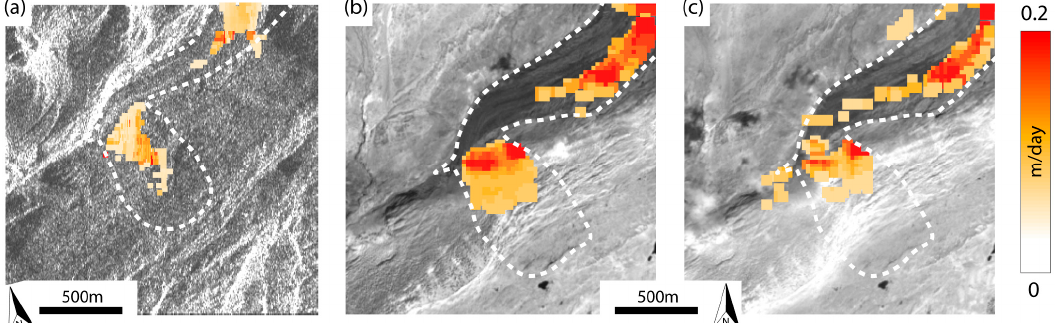
Figure 4. Best results obtained with the DIC analysis applied on the Sentinel-1 and Sentinel-2 datasets over the Moosfluh unstable slope. White boundary delineates the approximate area of the Aletsch glacier and Moosfluh slope instability (cf. Figure 1). ( a ) Resultant of the surface velocities measured across-track and along-track directions of Sentinel-1 in the period 08 June–18 October 2017. Background map is the SAR intensity for the SLC image 8 June 2017 (slant range oriented towards north); ( b – c ) Resultant of the horizontal surface velocities (E-N directions) measured on Sentinel-2 track R108 and R065 in the periods 19 July–17 October and 26 June–14 October 2017, respectively. Background maps are the surface reflectance for the images 19 July 2017 and 26 June 2017, respectively. Surface velocities in the lower portions of the Moosfluh instability and in the central part of the Great Aletsch glacier are well mapped by DIC. Inaccurate/outlier DIC values are masked out. However, in the S1 pairs of 6- and 12-days the noise is very high. Instead, due to different acquisition parameters and/or atmospheric conditions (e.g., different sun angles, diffused and/or local cloud cover over Moosfluh, etc.), the number of S2 pairs suitable for DIC was severely reduced (see also Supplementary Materials, Table S4). For this reason, we have identified among the dataset image pairs providing reliable results, releasing the time constraint and targeting the average displacement rates. Several DIC attempts were performed and for both S1 and S2 data we obtained results in agreement with our ground observation, only with data pairs attaining temporal separations of several months. In Figure 4a, we show the results for a S1 pair spanning the summer period between June and October, 2017. In the lower portions of the Moosfluh slope, decorrelated in the results obtained with standard DInSAR (see Section 3.1), the DIC results show large surface velocities (up to 0.15 m/day). This is in agreement with the DIC results obtained on the two S2 tracks, with values reaching up to 0.2 m/d in the portions near to the glacier tongue. Differences in surface displacement rates and their areal distribution between S1 and S2 DIC results can be observed due to different noise levels in the source imagery and/or also due to the different acquisition geometries (~40 degrees from vertical looking angle for S1, almost nadir for S2). 4. Discussion When slope deformation suddenly increases, serious concerns are posed to elements at risk, such as population and/or infrastructures located within the area of influence of a potential landslide event [41]. For this reason, the selection of monitoring approaches aimed at managing the critical scenarios is crucial [42]. Spaceborne and airborne remote sensing data are usually exploited to identify and/or map areas showing signs of slope activity and threated more as a long term planning tool, while ground based monitoring technologies are favored in case of Early Warning Systems aimed at providing timely information during the ultimate stages towards failure. Advances in spaceborne technology, particularly connected with the advent of the ESA Copernicus program, have pushed